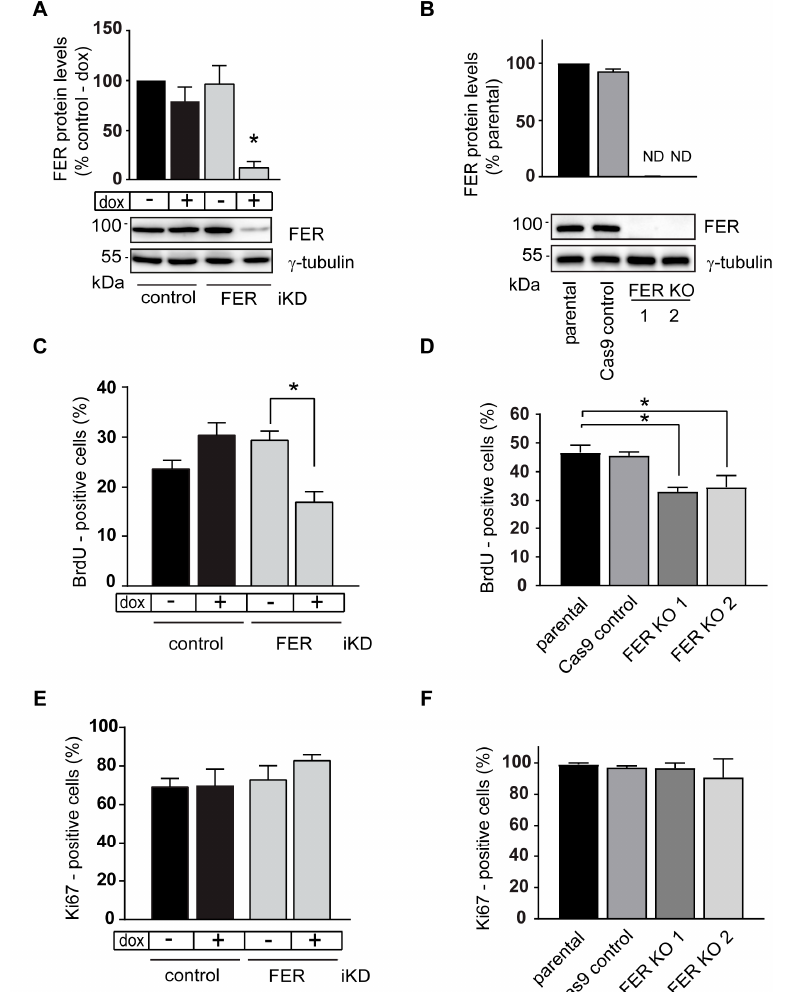
Figure 1. S-phase abnormalities in FER kinase-deficient melanoma cells. (A) Inducible knockdown (iKD) of FER in melanoma cells. 131/4 ‐ 5B1 cells were transduced with lentivirus encoding doxycycline (dox) ‐ inducible control or FER shRNA. Cells were cultured for 120 h in the absence ( − ) or presence (+) of 2 μ g/mL doxycycline (dox) and FER kinase was detected by immunoblot. γ‐ tubulin was used as a loading control. ( B ) Generation of FER knockout (KO) melanoma cells. A375 ‐ MA2 melanoma cells were transfected with plasmids encoding wild type Cas9 endonuclease and single ‐ guide RNAs targeting FER exon 1 or exon 3. Single cell clones were isolated and successful targeting of FER was confirmed by immunoblot. Histograms represent mean FER protein levels ± SEM ( N = 3) normalized to γ‐ tubulin and expressed relative to control — dox cells ( A ) or to parental cells ( B ), which are set to